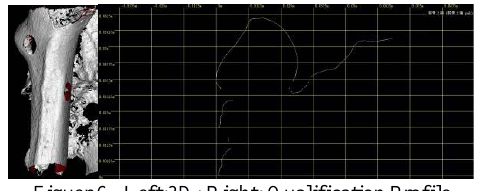
Figuer 6. Left:3D; Right: Qualification